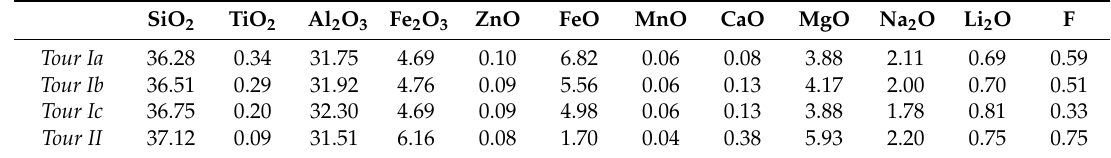
Table 1. Elemental median concentration values (wt %) characterizing each tourmaline